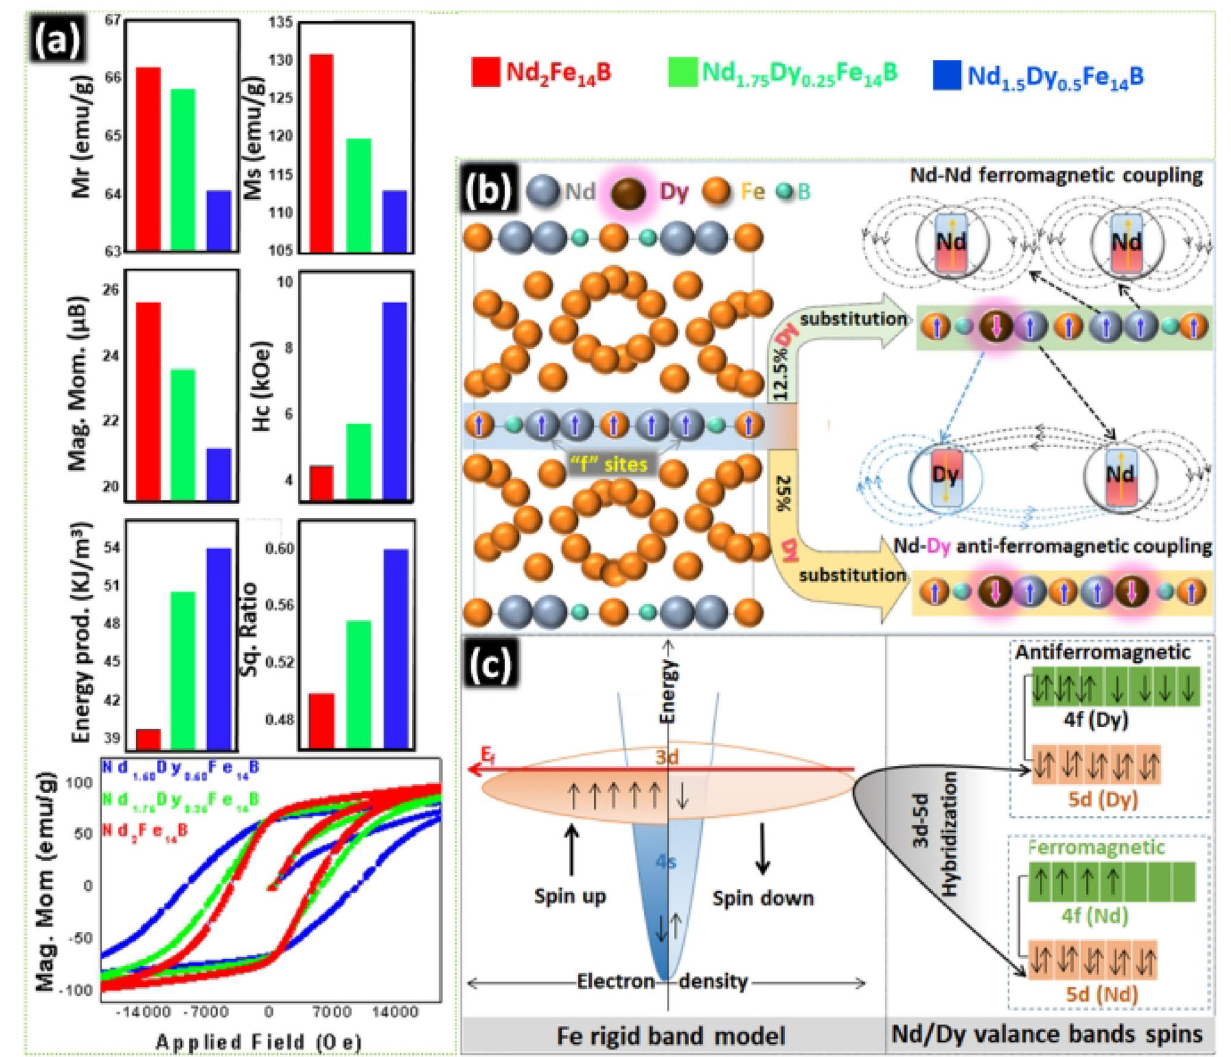
Figure 6. ( a ) M–H curves, Mr, Ms, Magnetic moment, Hc, energy density and squareness ratio of Nd 2 Fe 14 B, Nd 1.75 Dy 0.25 Fe 14 B and Nd 1.5 Dy 0.5 Fe 14 B particles. ( b ) Schematic illustration to explain the ferro and anti- ferromagnetic coupling between Nd, Dy and Fe ( c ) Explanation of coupling and hybridization between Nd, Dy and Maximum magnetic moment value (24.13 μB) of Nd 2 Fe 14 B obtained during rotation was lower than the mag- netic moment values obtained from M–H curves (25.50 μB). Reduced value of magnetic moment was observed because of weak applied magnetic field (200 Oe) during the rotation of the magnetic particles. However, the trend of magnetic moment variation for both the Nd 2 Fe 14 B and Nd 2−x Dy x Fe 14 B was same. Conclusively, substi- tution of Dy for Nd does not affect the anisotropic patterns of the crystal, however, value of the energy density can be changed. Figure S-8 explains the interaction of the applied magnetic field and the electron spin density of Nd 2 Fe 14 B during the rotation. Magnetic moments of Nd 2 Fe 14 B, Nd 2−x Dy x Fe 14 B and Nd were calculated theoretically by full potential lin- earized augmented plane wave method, as implemented in the Wien2k code. Individual magnetic moments of Nd and Dy atoms at different sites were also calculated theoretically by this method. Theoretically calculated magnetic moment values for Nd 2 Fe 14 B, Nd (f) and Nd (g) were 30.20, 3.32 3.30 μB, respectively. Experimentally determined values for the Nd Theoretically Nd always occupies the “g” site in Nd 2 Fe 14 B, Nd 1.75 Dy 0.25 Fe 14 B and Nd 1.5 Dy 0.50 Fe 14 B 19–21 . This is also confirmed in this work (Fig. 4). Hence in case of Nd 1.75 Dy 0.25 Fe 14 B and Nd 1.5 Dy 0.50 Fe 14 B there is negligible change in the magnetic moment on the “g” site after substitution. In Nd 2 Fe 14 B formula unit, Nd is distributed equally among 50% “f” and 50% “g” sites. Magnetic moment on “f” and “g” sites of in Nd 2 Fe 14 B is determined as 2.69 and 2.67 μB, respectively. In Nd 1.75 Dy 0.25 Fe 14 B and Nd 1.5 Dy 0.50 Fe 14 B, Nd occupies 75% and 50% “f” sites, simultaneously Dy occupies leftover 25% and 50% “f” sites respectively. Hence magnetic moment on one “f” sites in Nd 1.75 Dy 0.25 Fe 14 B and